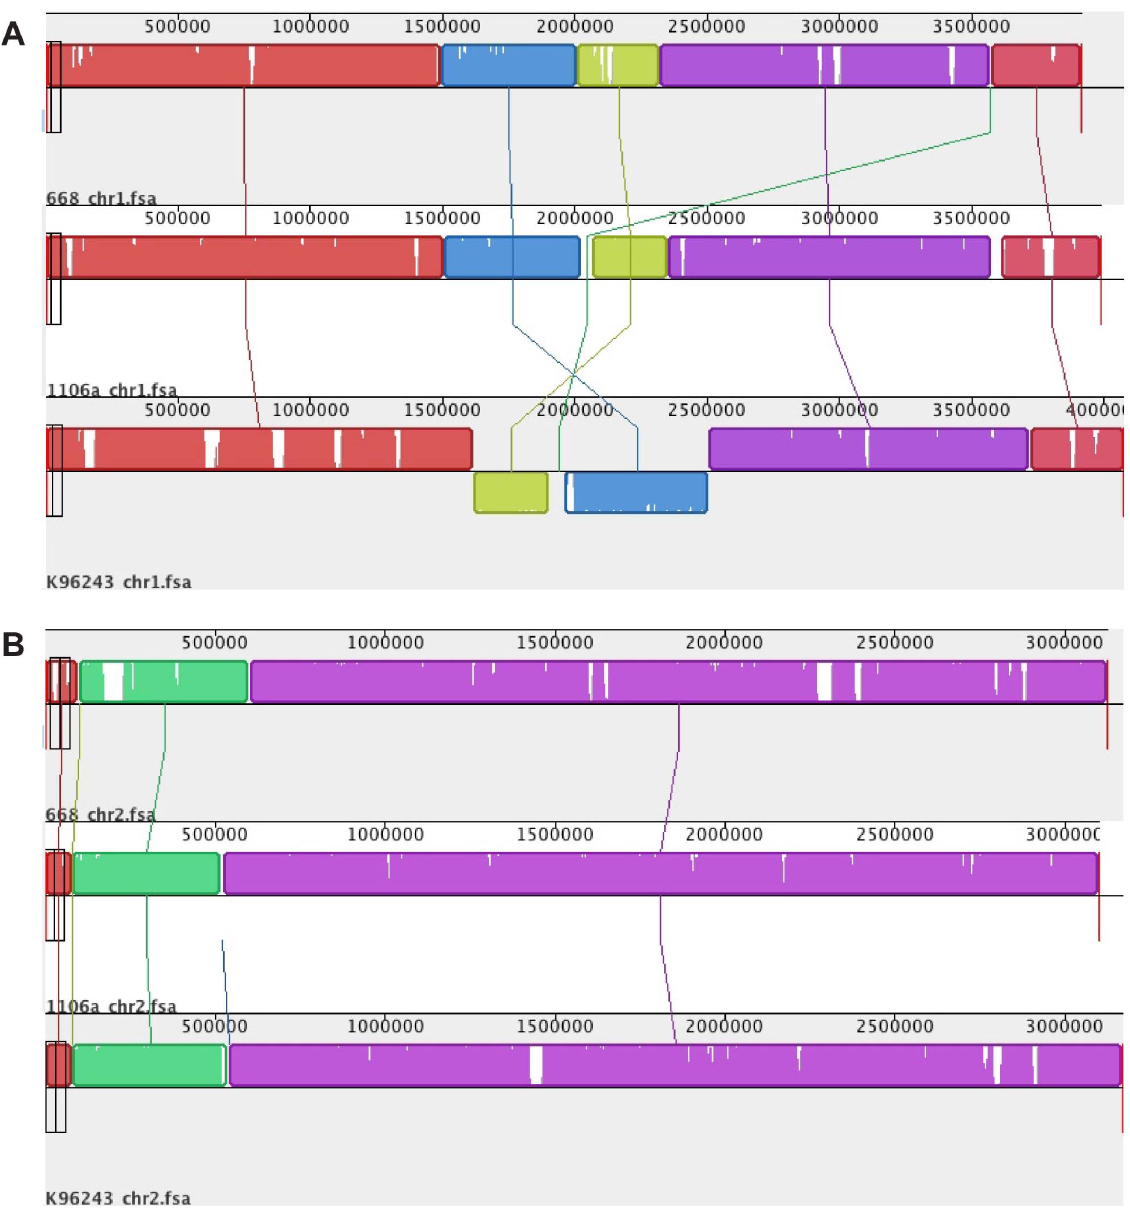
Fig. 1. Mauve alignment of B. pseudomallei chromosomes 1 (panel A) and 2 (panel B). Homologous regions in the genomes are illustrated as locally collinear blocks of the same color that are linked across the chromosomes. The three genomes showed five homologous regions in chromosome 1, and three homologous blocks in chromosome